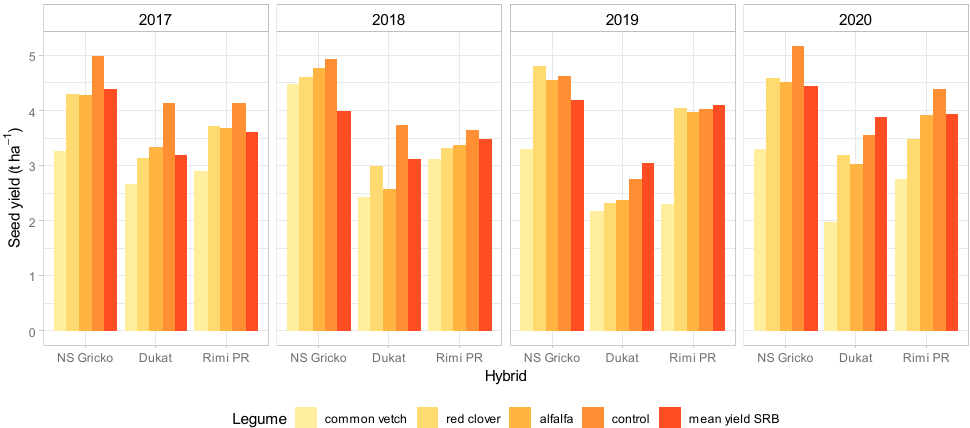
Figure 5. Sunflower seed yield in intercrops compared to average yield in multi-environment trials in Republic of Serbia agroecological conditions (average yield SRB-unpublished data from IFVCNS multi-environment trials).